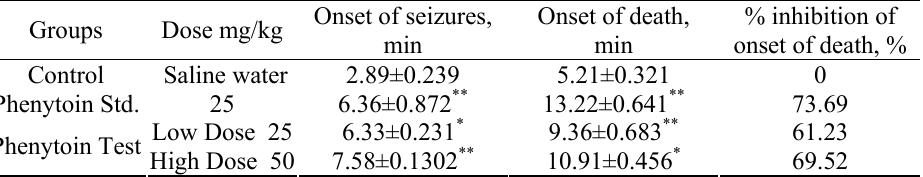
Table 4. Data of anticonvulsant activity by PTZ-induced seizures in mice